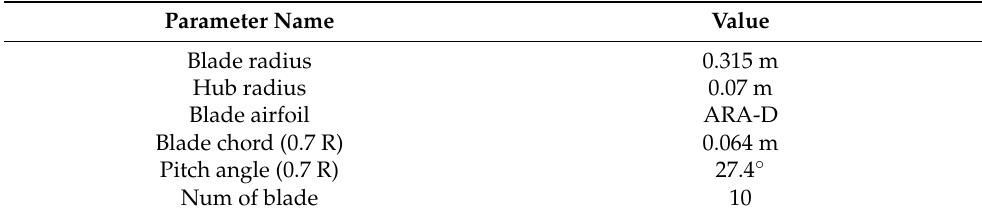
Table 4. Geometric parameters of Blade 1.